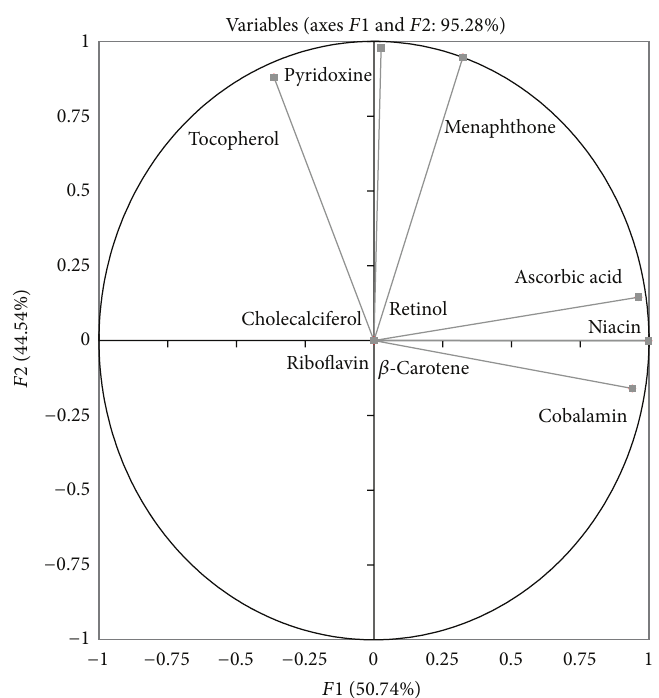
Figure 1: Plots of the principal component scores for vitamin contents of okra pods.